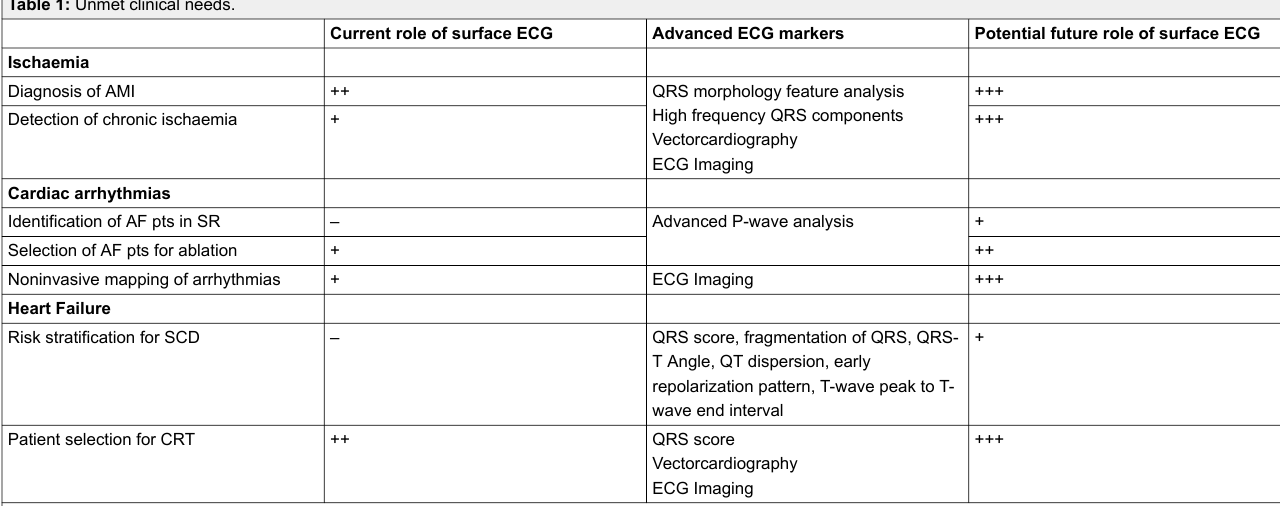
Table 1: Unmet clinical needs.